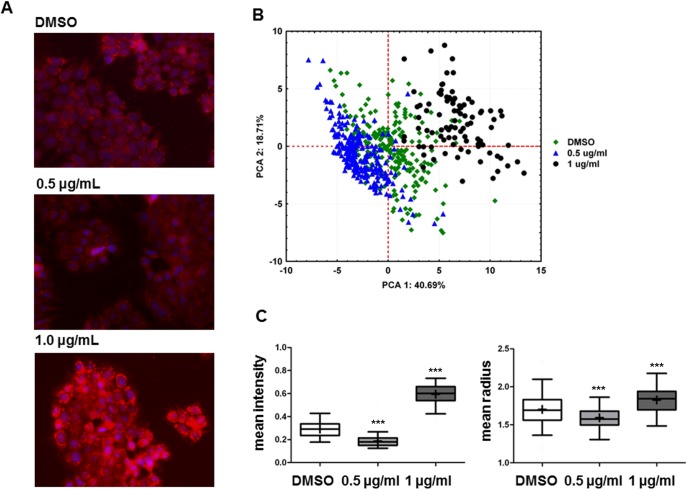
Quantitative analysis of fluorescence microscopy by CellProfiler software.A) Overlay of two fluorescent channels: blue, nucleus (HO-33342); red, mitochondria (MitoTracker). B) Principal component analysis of 40 mitochondrial parameters (object intensity, size and shape of objects) discriminated between treatments (portoamides 0.5 μg/mL, 1 μg/mL) and solvent control (DMSO). Factors that contributed mainly (> 0.85) to PC1 were related to intensity measurements (IntegratedIntensityEdge, LowerQuartileIntensity, MaxIntensityEdge, MaxIntensity, MeanIntensityEdge, MeanIntensity, MedianIntensity, MinIntensityEdge, MinIntensity, StdIntensityEdge, UpperQuartileIntensity), while parameters related to size and shape (AreaShape_Area, AreaShape_MaxFeretDiameter, AreaShape_MaximumRadius, AreaShape_MeanRadius, AreaShape_MedianRadius, AreaShape_MinFeretDiameter, AreaShape_MinorAxisLength, AreaShape_Perimeter) contributed mainly (> 0.85) to PC2. C) Detailed analysis of two mitochondrial parameters, mean fluorescence intensity and mean radius, are shown. Data are represented as box-whisker plots and statistically significant differences between the solvent control and the treatment groups are indicated by asterisks (Kruskal-Wallies, Dunn’s test, *** = p<0.001).